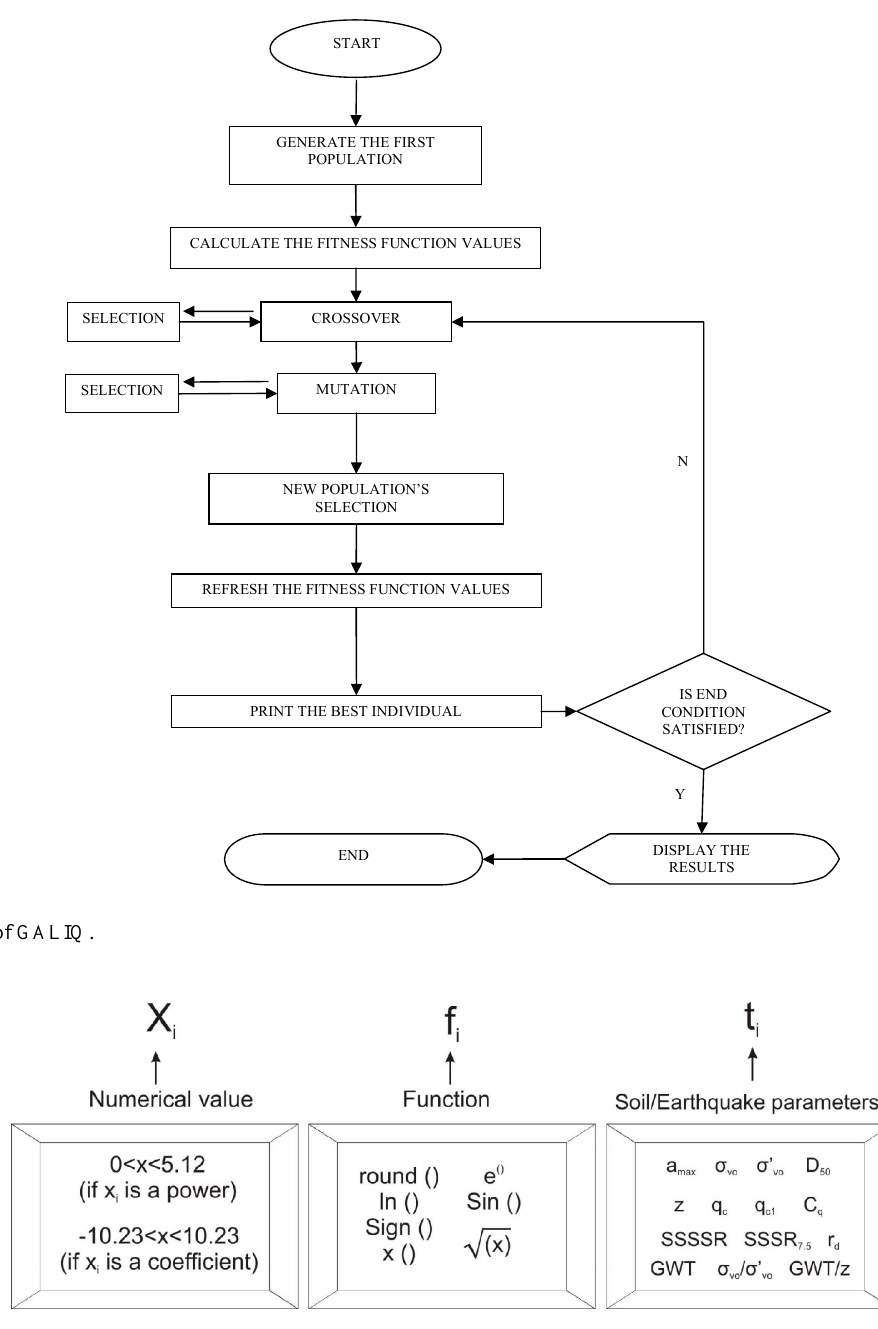
Fig. 3. Probable values of X i , f i and t i variables.